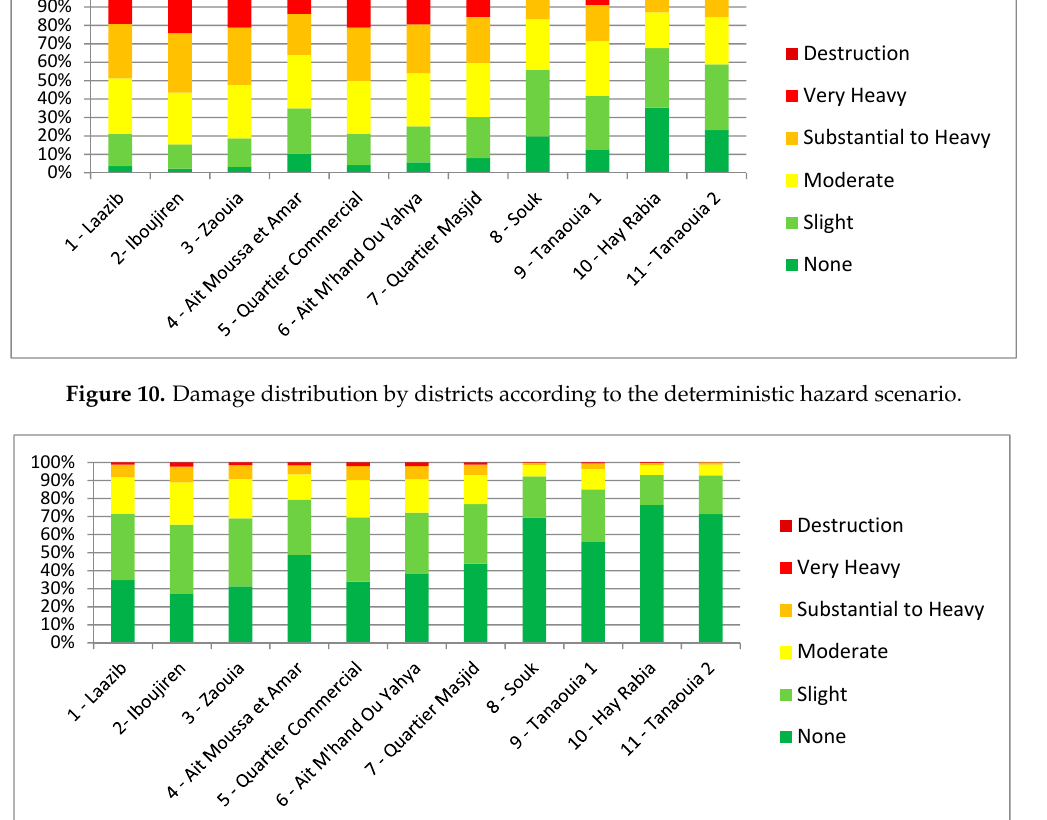
Figure 11. Damage distribution by districts according to the probabilistic hazard scenario.